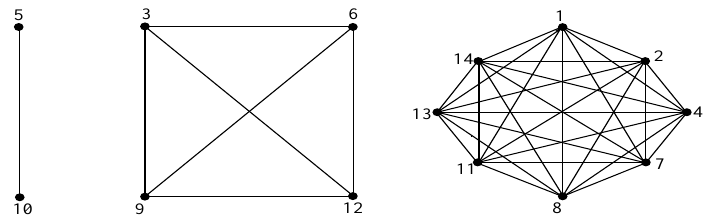
Figure 2. The associate ring graph AG ( Z 15 )